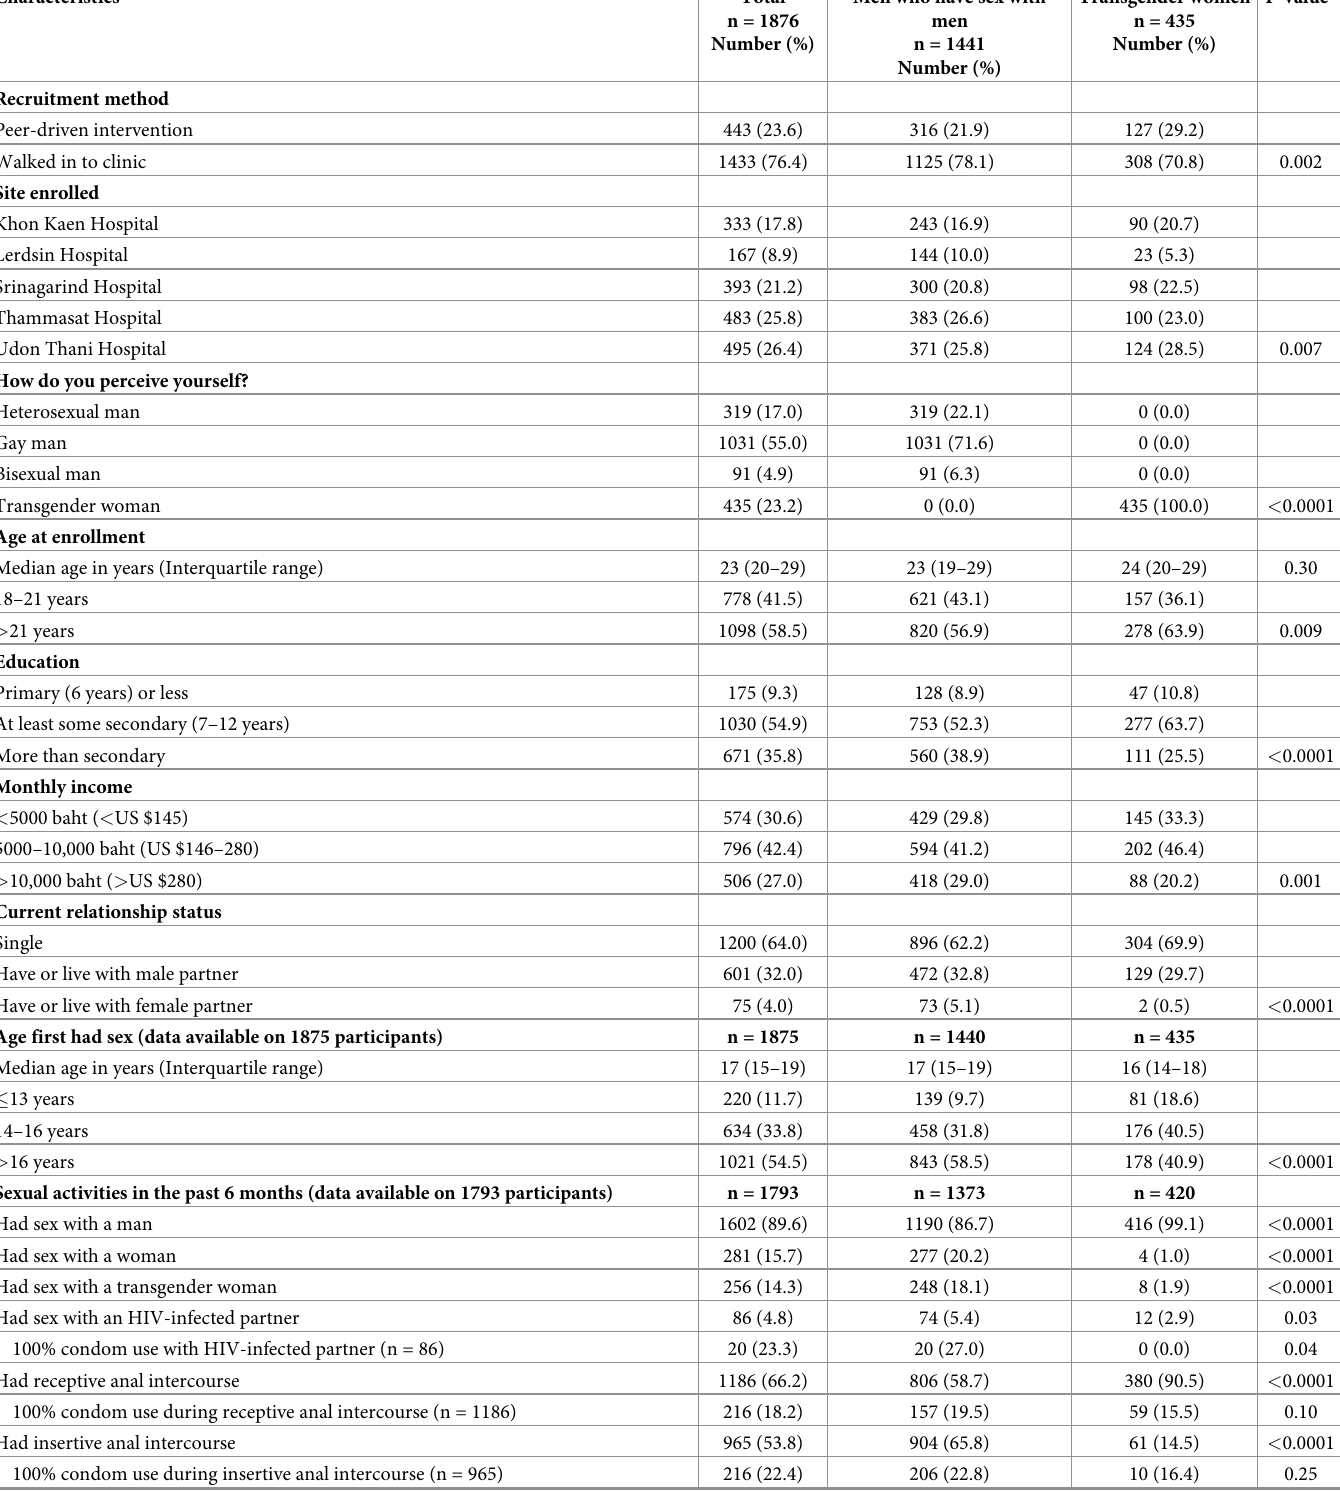
Table 1. Baseline characteristics of participants in the test, treat, and prevent HIV program, Thailand, 2015–2016.